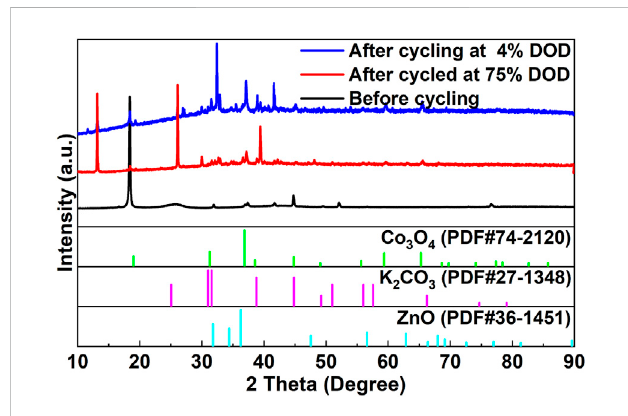
FIGURE 10 XRD results of the Co 3 O 4 /CB air cathodes before and after cycling, respectively.